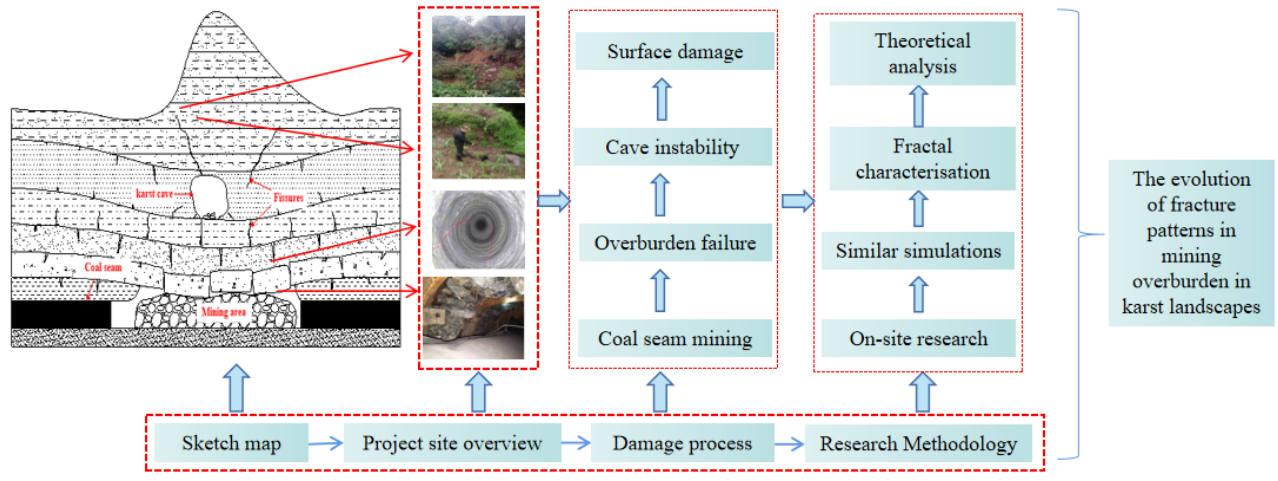
Figure 2. Overview of the methodology.